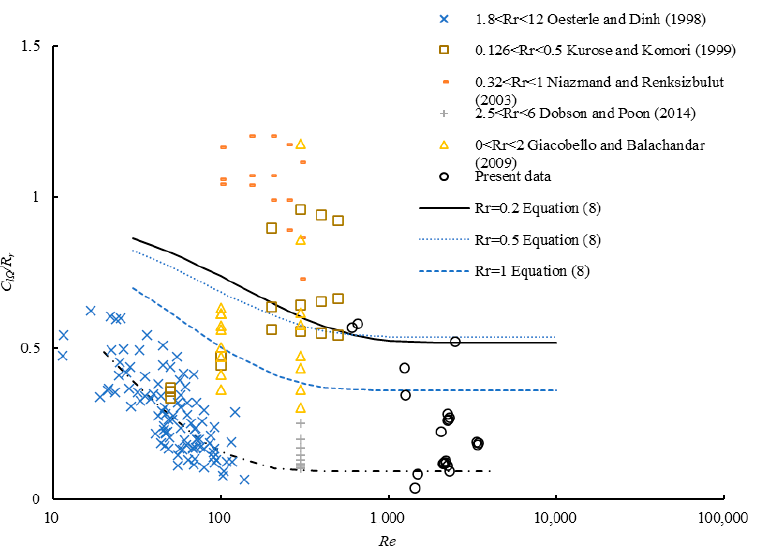
Figure 5. The correlation between the rate of the lift coefficient to dimensionless angular speed and the Reynolds number [7,13,14,33,34].